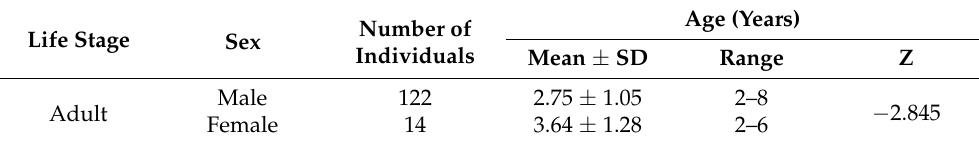
Table 2. Summary of age (mean ± SD) in the adult population of boreal digging frogs ( K. borealis ) in Lake Sihwa. Number of Life Stage Sex Individuals